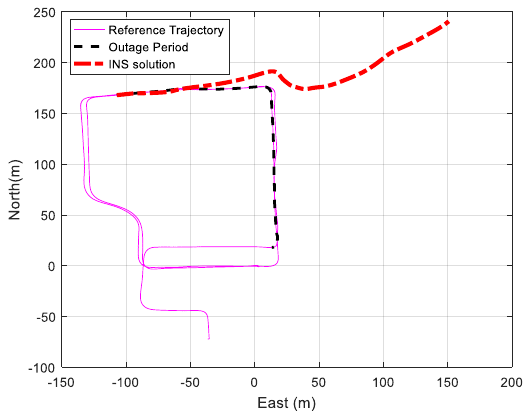
Figure 19. First Trajectory INS standalone navigation solution for 60 seconds GNSS signal outage